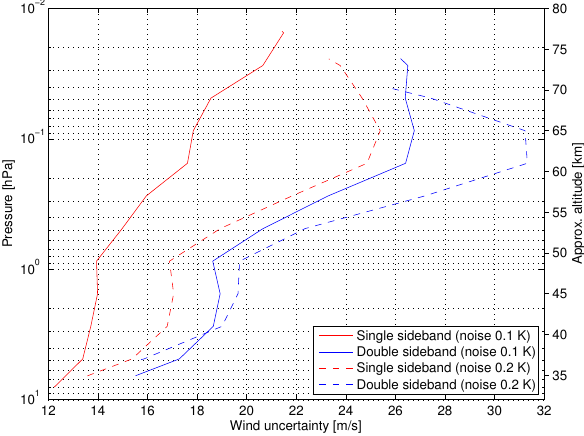
Figure 12. Standard deviation of the resulting profiles in the Monte Carlo simulation displayed in Figs. 10 and 11.